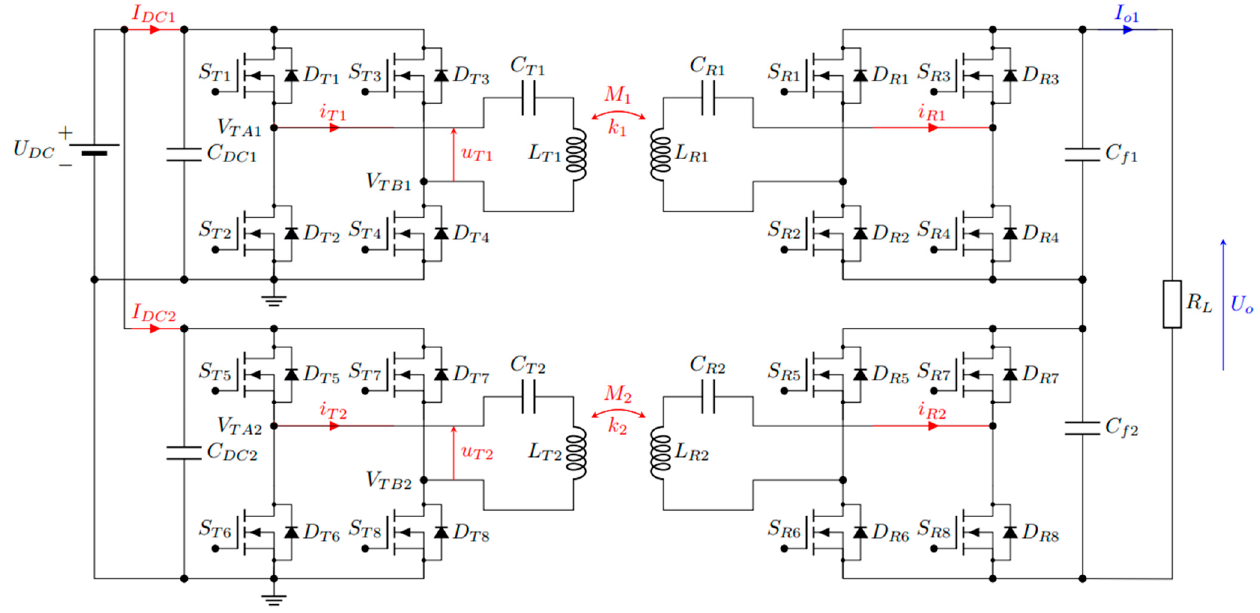
Figure 2. Simplified circuit of the IPT system using a double DD coil.